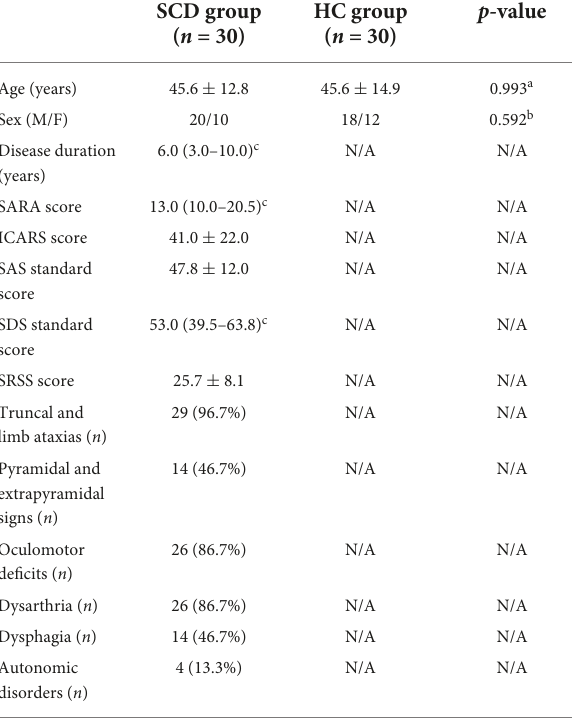
TABLE 1 The demographical information and clinical characteristics of SCD group and HC